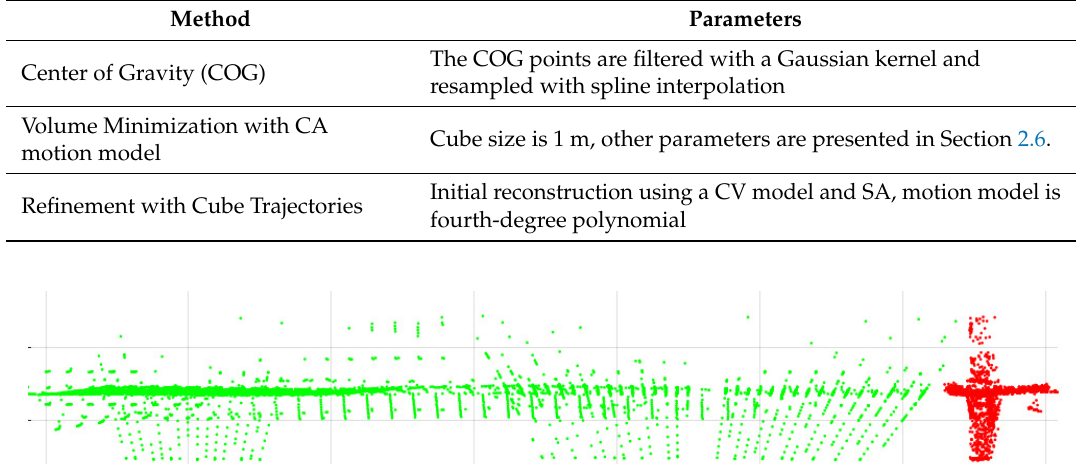
Figure 10. Sensor georeferencing: points from the calibration board in the sensor coordinate system depicted with red, the norm of the board surface is shown with red lines, blue dots are the board corners measured with total station, the blue lines are the norms of the board surface in the global coordinate system, green points depict the points after transforming the board points from the sensor to the global coordinate system, and the red circle marks the sensor position. Table 3. Investigated algorithms for Test #1.